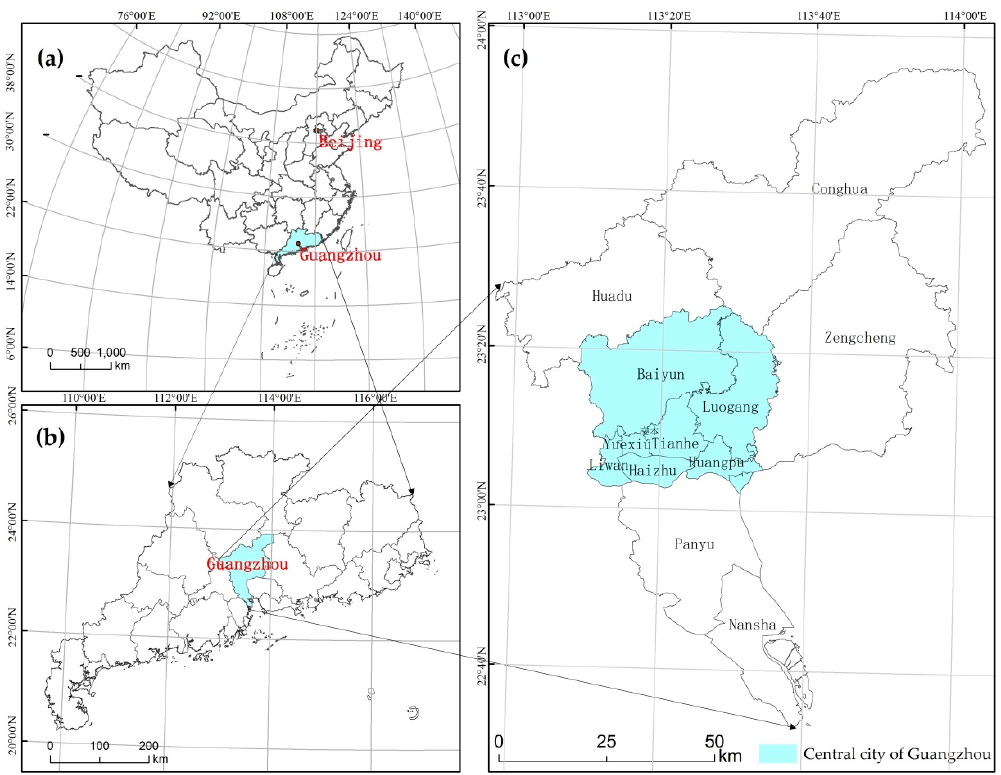
Figure 2. Study area: ( a ) location of Guangdong province in China; ( b ) Guangzhou’s location in Guangdong province; ( c ) central city of Guangzhou.